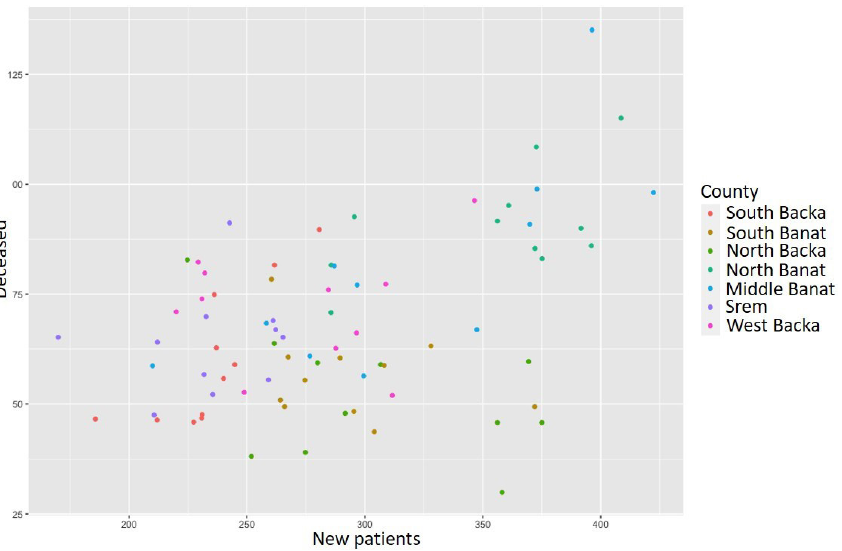
Figure 3. Acute coronary syndrome incidence and mortality rate ratio from 2010 to 2020.